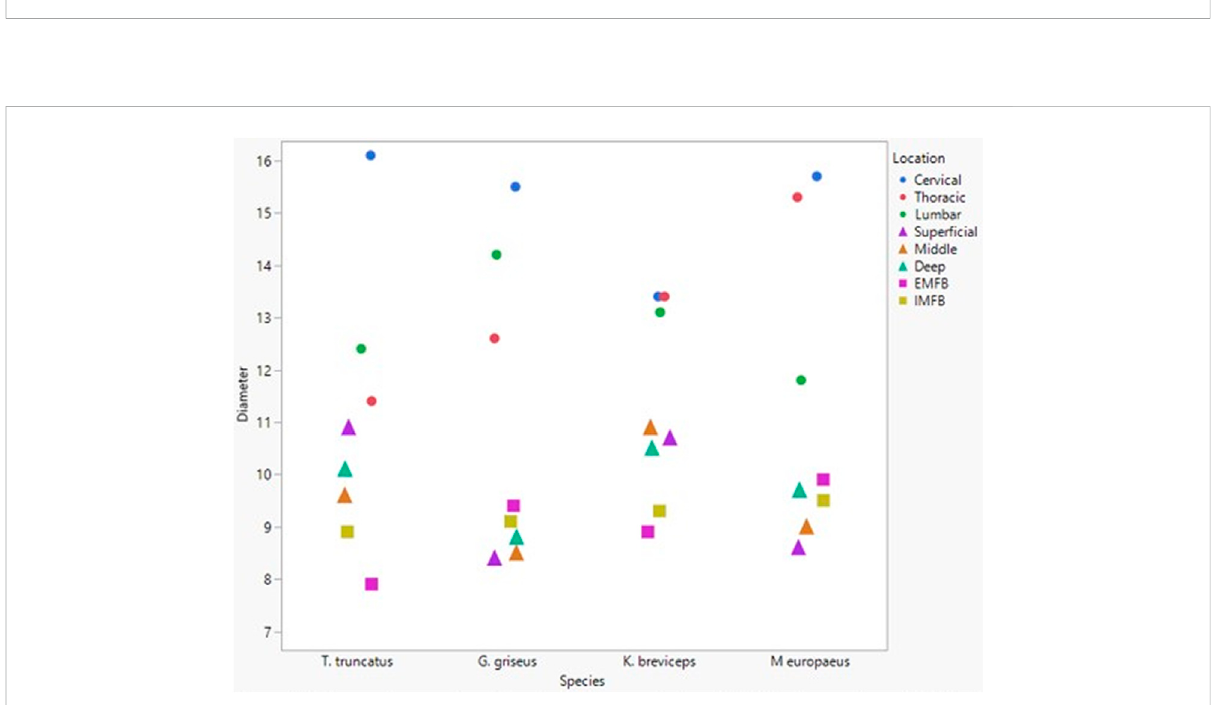
FIGURE 9 Mean microvascular diameter between odontocete blubber layers (super fi cial, middle, deep) McClelland et al., 2012; triangle), acoustic fats (intramandibular fat bodies — IMFB and extramandibular fat bodies — EMFB) (Gabler et al., 2018; square), and length of spinal cord (cervical, thoracic, lumbar) (circle)